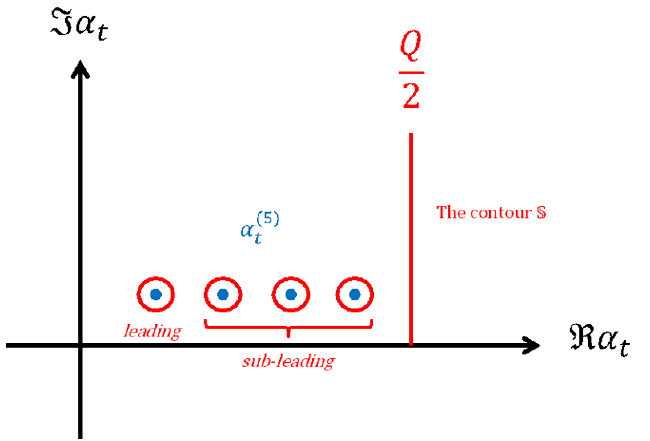
Figure 13 . This (cid:12)gure shows from where the sub-leading contributions to the blocks are obtained. which can be easily checked using the series expansion of (1 (cid:0) x ) (cid:0) 2 h L . Therefore, we can conclude that the sub-leading contributions come from the poles with non-zero m; n ,